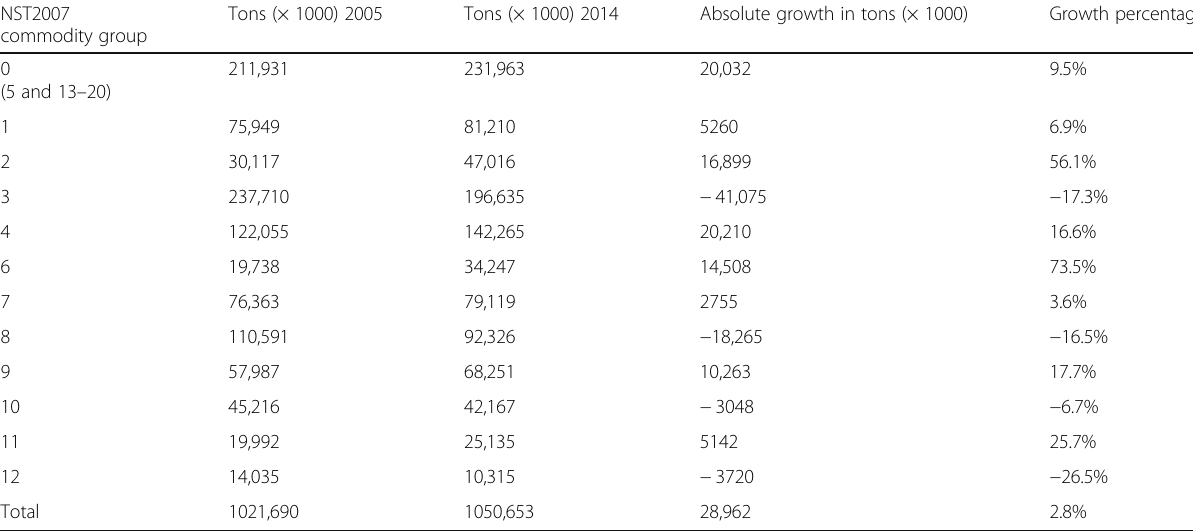
Table 7 Development of cargo markets between 2005 and